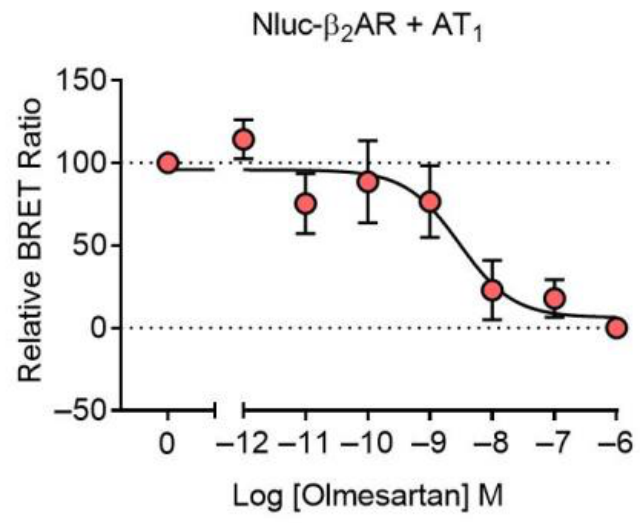
Figure 4. Competition binding of BODIPY-AngII to the AT 1 - β 2 AR heteromer. Cells expressing Nluc- β 2 AR + AT 1 were treated with 500 nM BODIPY-AngII in the presence of increasing concentrations of olmesartan. Data are normalized (100% being vehicle-treated and 0% being 1 µ M olmesartan-treated) and displayed as relative BRET ratio, mean ± SEM of four independent experiments.